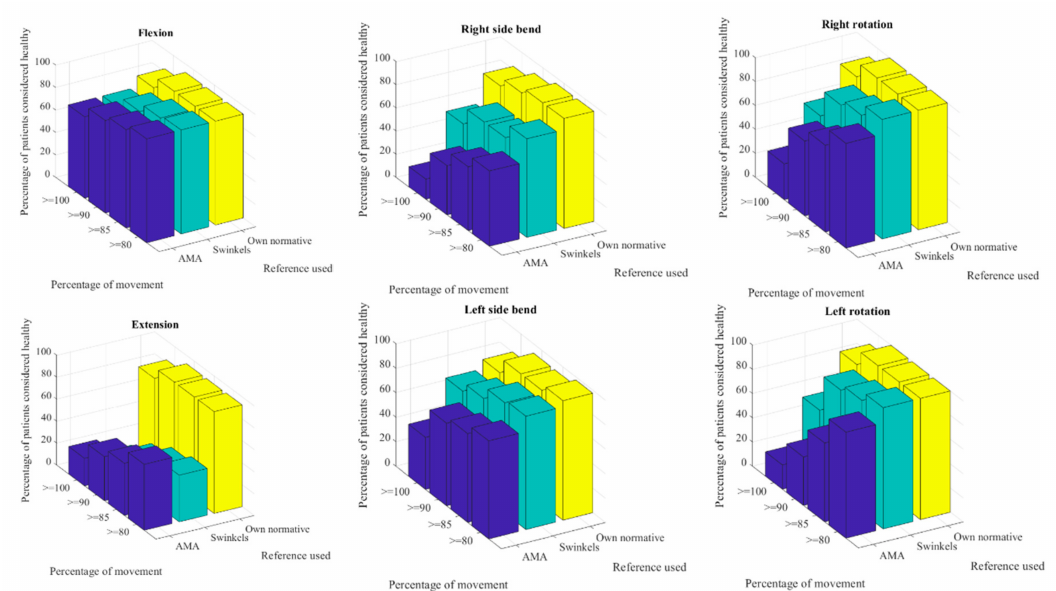
Figure 7. Percentage of controls included as non-pathological with each cut-o ff .